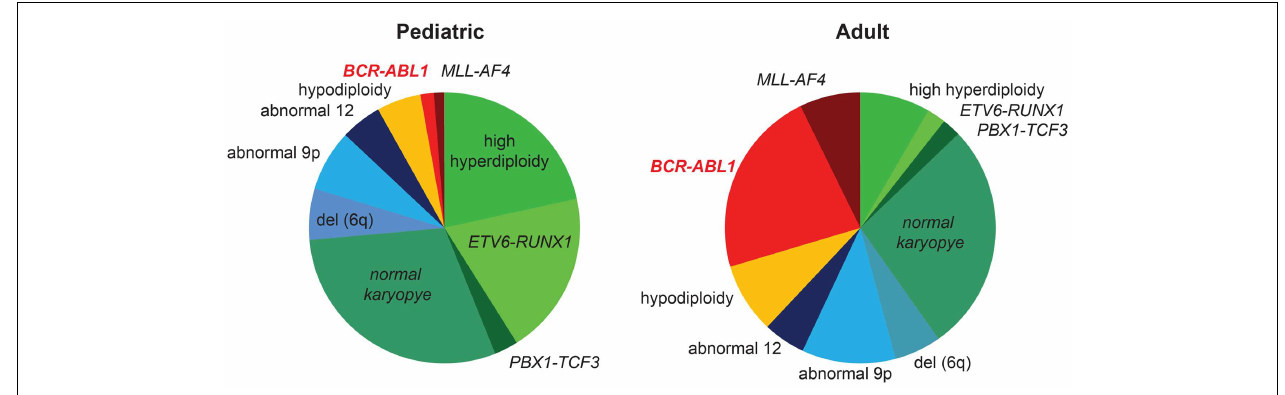
FIGURE 1 | Frequency of BCR/ABL1 rearrangement in pediatric and adult ALL . Cytogenetic abnormalities in pediatric ( > 1year) and adult patients with ALL are shown (5).The majority of children < 1year of age carry a rearrangement of the MLL -gene and are not included in this graph. Favorable cytogenetic abnormalities are represented in green, neutral in blue, and